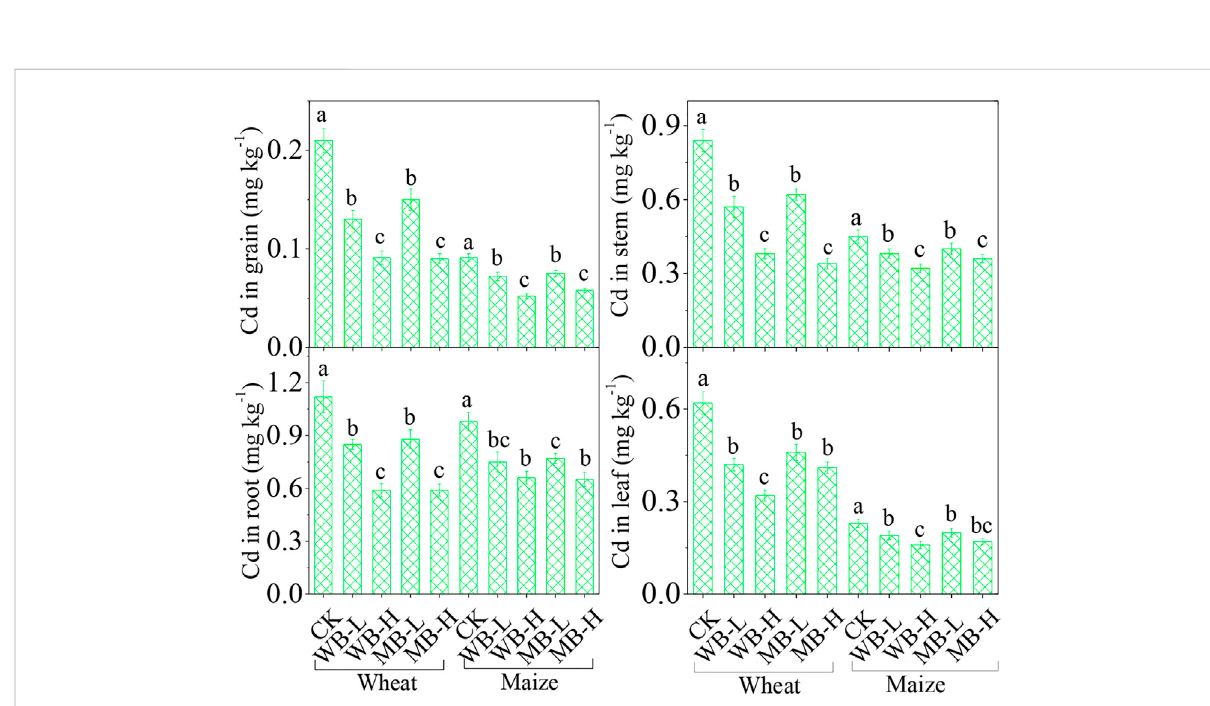
FIGURE 4 Effect of biochar on Cd concentrations in grain, stem, leaf, and root in wheat and maize.